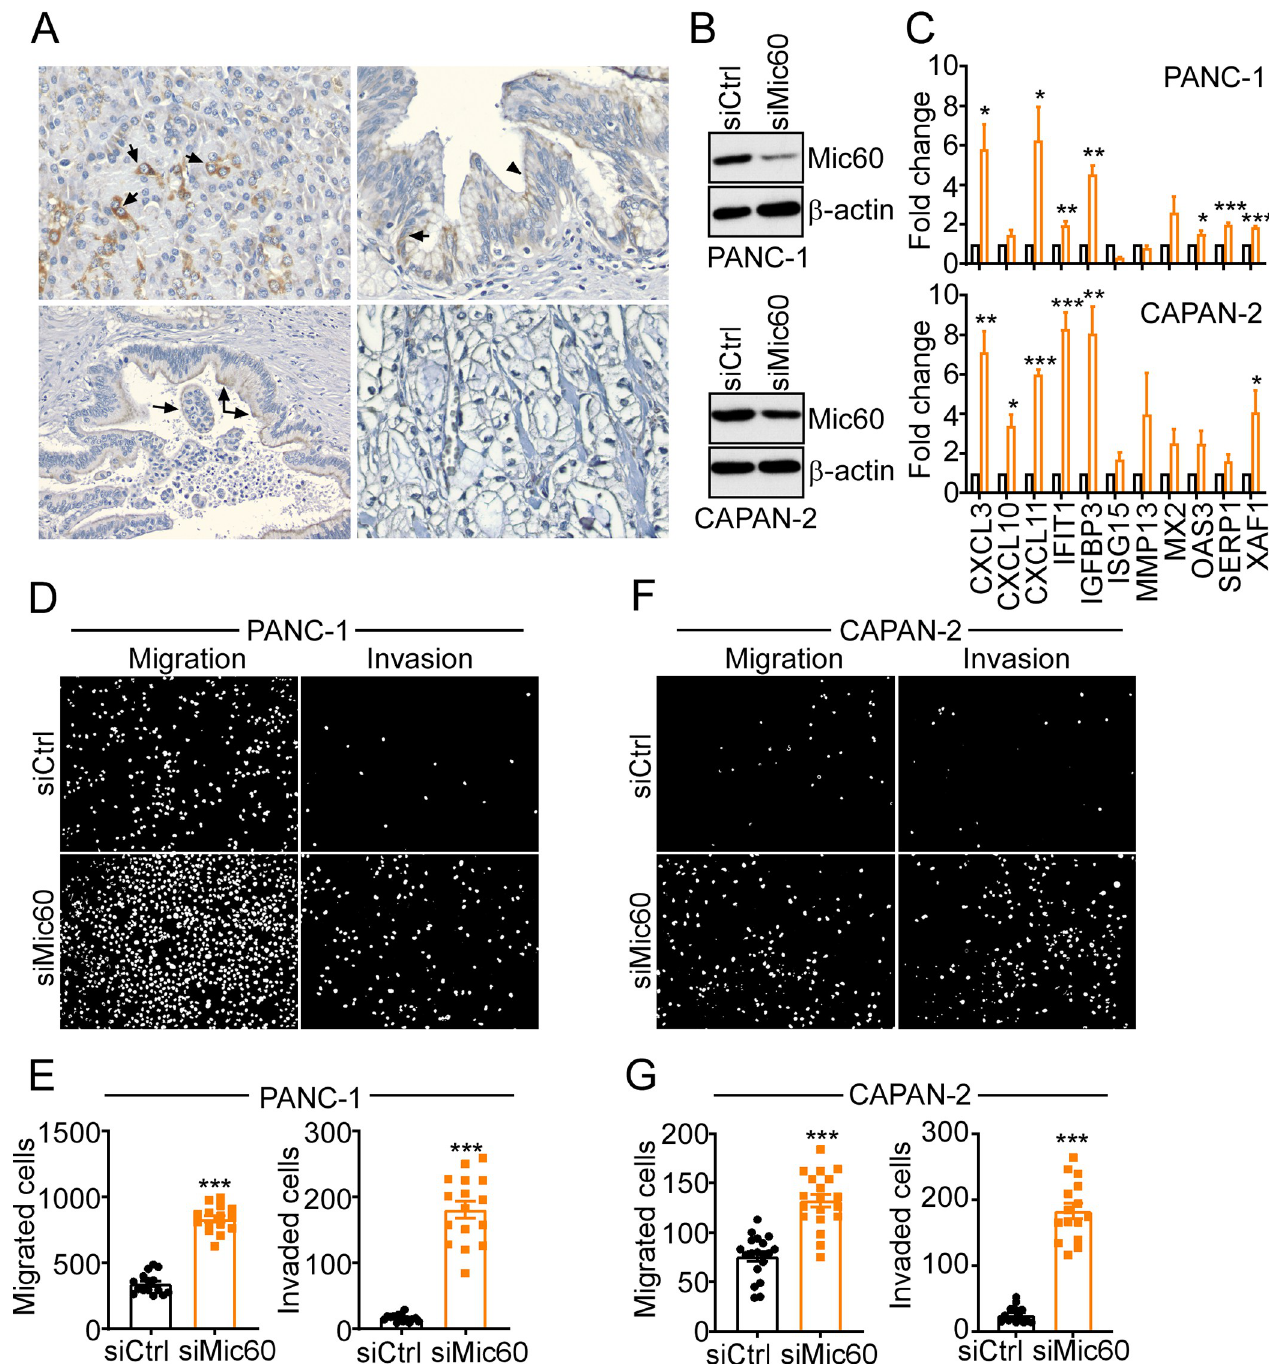
Fig 2. Characterization of Mic60 in pancreatic cancer. (A) Heterogeneous expression of Mic60 in PDAC patients by IHC. Top Left , arrows, perinuclear and cytoplasmic expression in normal pancreatic acini (x400). Top Right , perinuclear (arrow) and apical (arrowhead) cytoplasmic expression in high-grade pancreatic intraepithelial neoplasia (x400). Bottom Left , transition between Mic60-positive well differentiated tumor (double arrows) and Mic60-negative high- grade basaloid regions (single arrow) within the same tumor gland (x400). Bottom right , absent stain in high-grade basaloid PDAC (x400). A histoscore of Mic60 staining intensity was as follows: 0, absent; 1, low; 2, medium; 3, high. (B) PDAC cell lines PANC-1 ( top ) or CAPAN-2 ( bottom ) were transfected with control non-targeting siRNA (siCtrl) or Mic60-directed siRNA (siMic60) and analyzed by Western blotting. (C) The conditions are as in (B) and transfected cell lines were analyzed for differential expression of the indicated genes in the Mic60-low gene signature by qPCR. Mean ± SEM (n = 3). � , p = 0.01–0.04; �� , p = 0.001–0.004; ��� , p < 0.0001. (D-G) The conditions are as in (B) and transfected PANC-1 (D-E) or CAPAN-2 (F-G) cells were analyzed for cell motility and representative images of DAPI-stained nuclei of migrated or invaded cells were visualized by fluorescence microscopy (D-F) and quantified (E-G). Mean ± SEM (n = 3). ��� , p < 0.0001. https://doi.org/10.1371/journal.pone.0273520.g002 PLOS ONE | https://doi.org/10.1371/journal.pone.0273520 October 12,